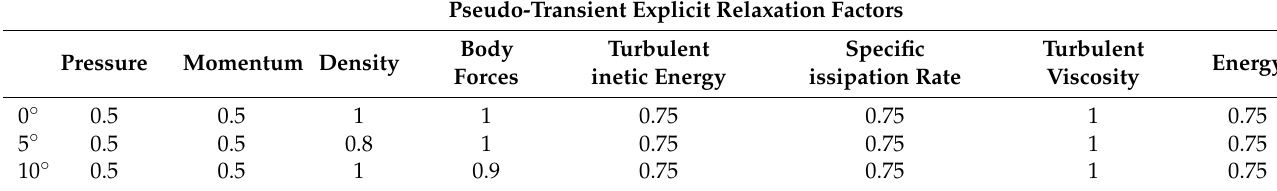
Table 4. The specific parameters of solution